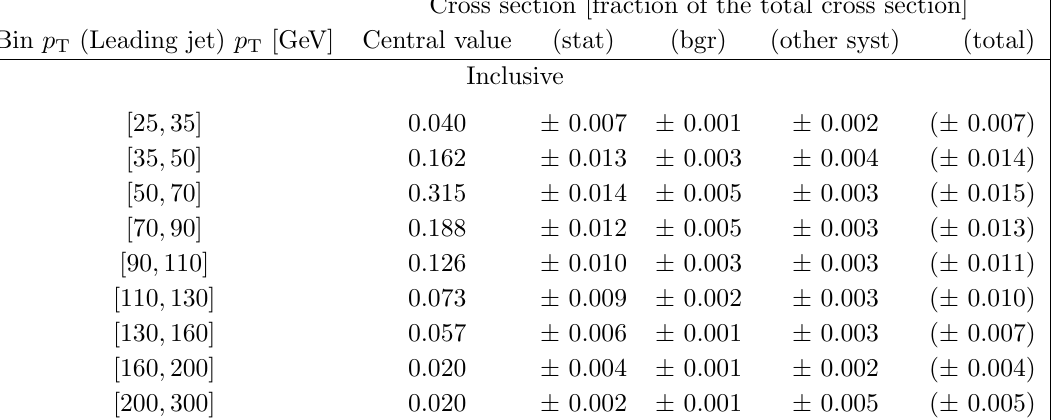
Table 11 . Di(cid:11)erential cross section in bins of p T (Leading jet). Values are expressed as a fraction of the total cross section. The inclusive (cid:12)nal state is